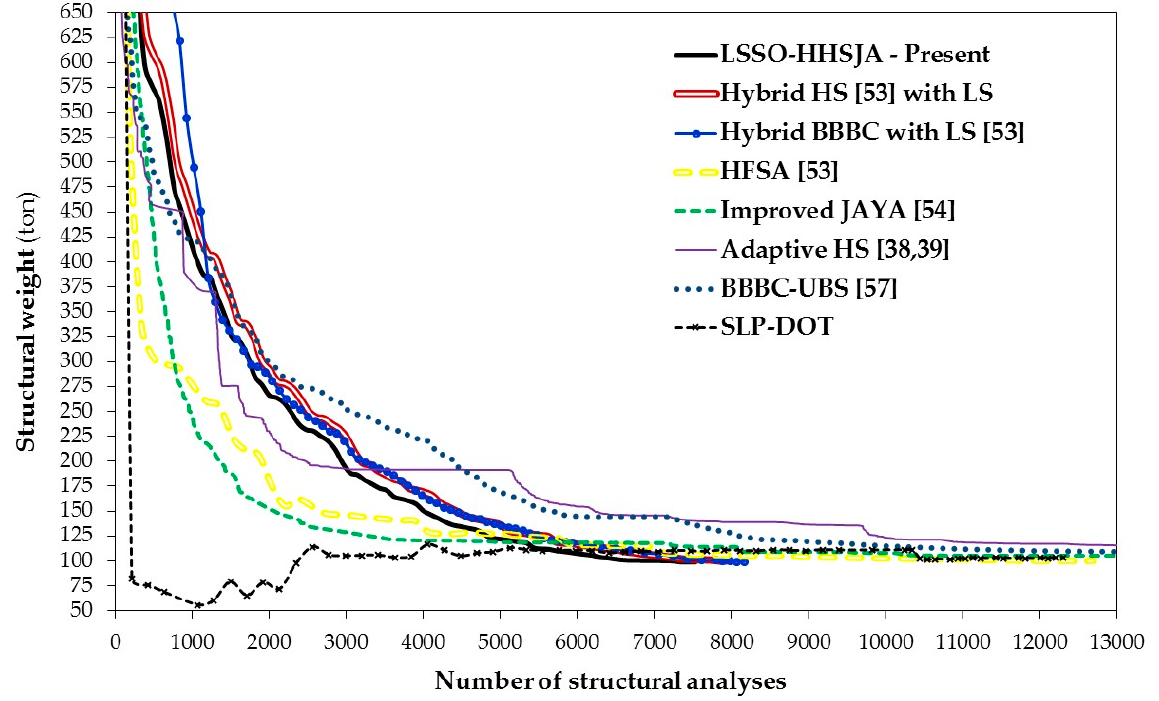
Figure 5. Convergence curves obtained for the 1938-bar tower design example.